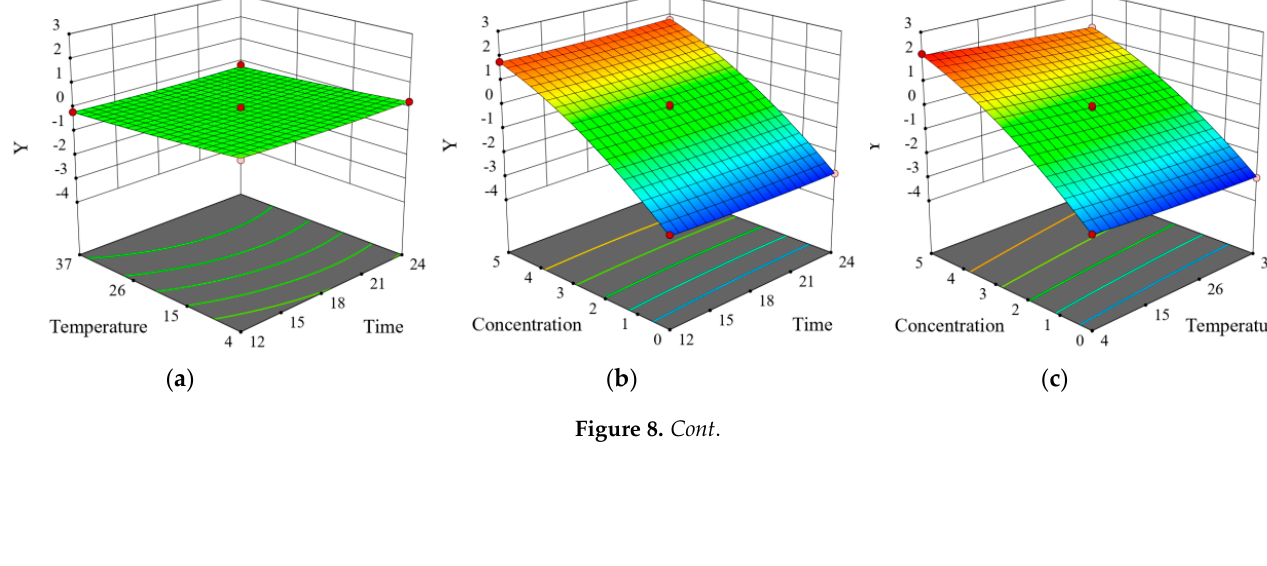
Figure 7. The contour plots showing the effect of interactions between ( a ) storage time and storage temperature, ( b ) storage time and CA concentration, and ( c ) storage temperature and CA concentration on Y. enterocolitica growth in raw pork. The response surface plots showing the effect of interactions between ( d ) storage time and storage temperature, ( e ) storage time and CA concentration, and ( f ) storage temperature and CA concentration on Y. enterocolitica growth in raw pork.